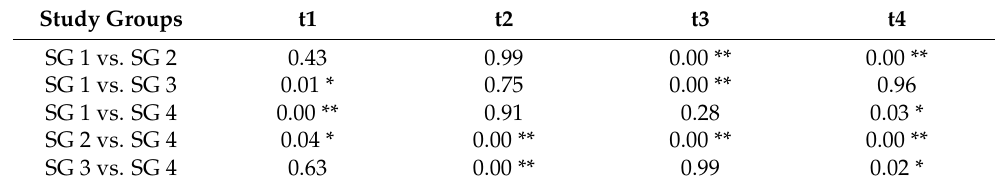
Table 2. Statistical correlation of VAS scores between each group immediately at end of treatment (t1), at 7 days (t2), at 1 month (t3), and at 6 (t4) months from the treatment. P: Wilcoxon signed-rank test. Study Groups t1 t2 t3